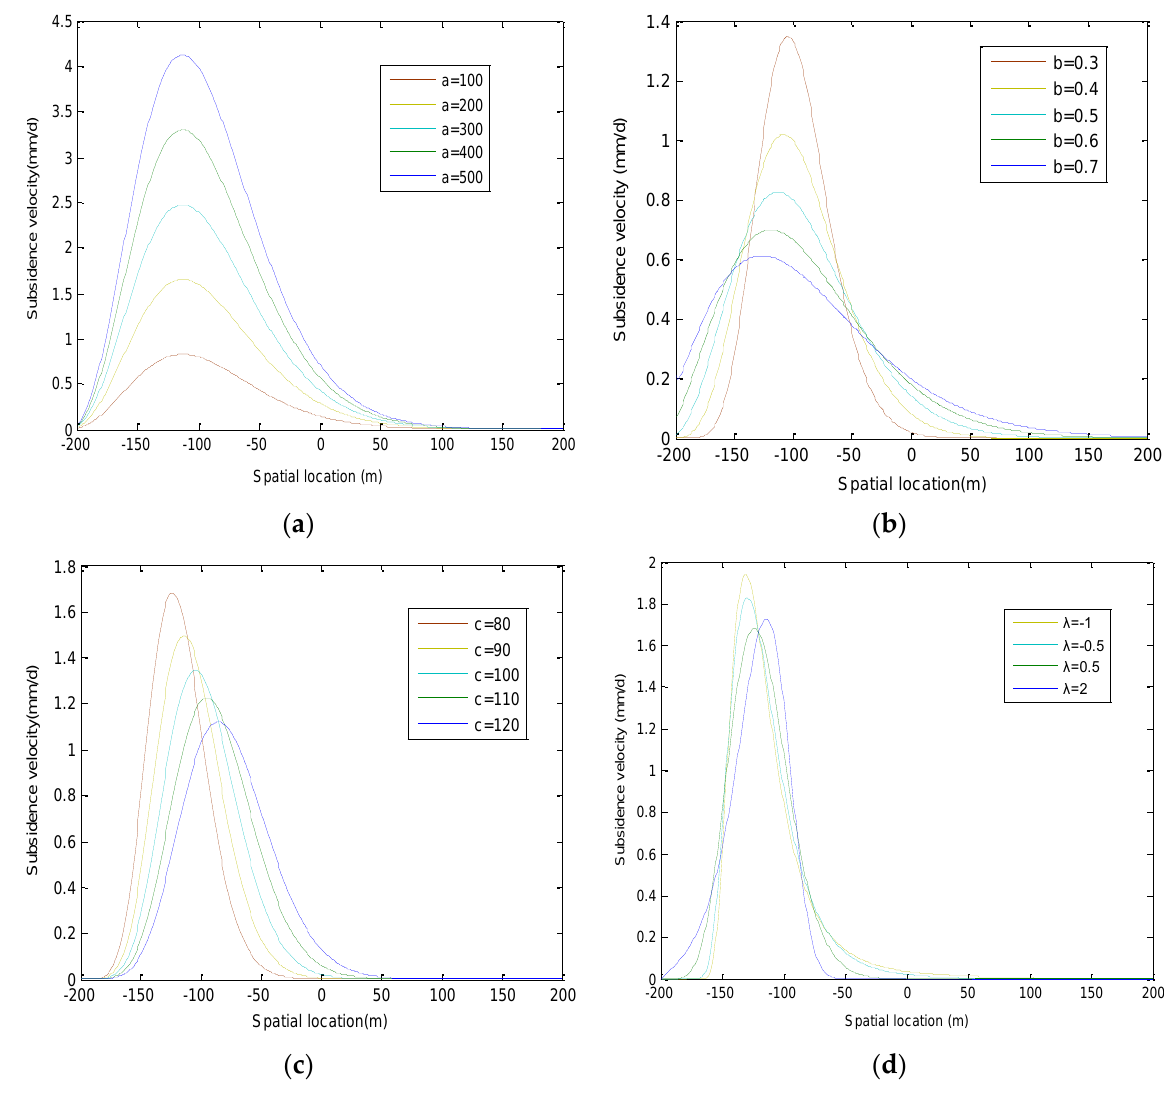
Figure 5. Model parameter analysis. ( a ) Influence of parameter a on curve shape, ( b ) Influence of parameter b on curve shape, ( c ) Influence of parameter c on curve shape, ( d ) Influence of parameter λ on curve shape.